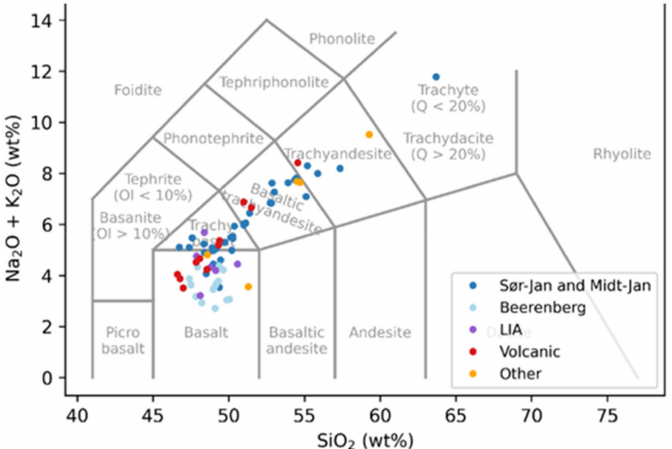
Figure 4. Rock-type classification based on the geochemistry of the samples. High-Mg ( n = 15) samples have been excluded as those are not classified with a TAS-plot. Additionally, samples JM2014- 01 and JM2014-02 have been excluded due to methodological problems with their geochemistry measurements (see Supplementary Table S1). The colors are the same as in Figure